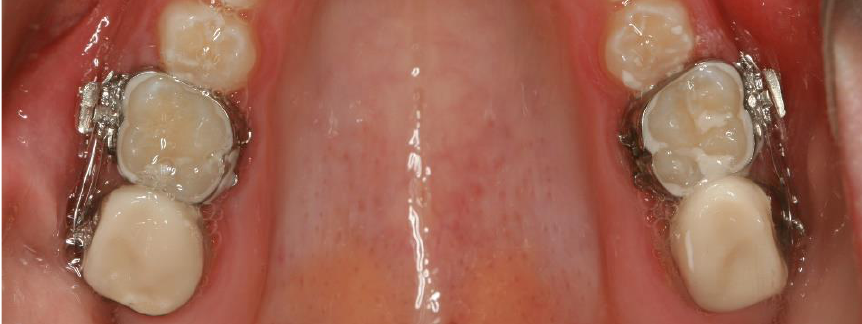
Figure 4. Crowns (with safety hooks) were produced using 3D computer design and additive manufacturing technology (selective laser melting (SLM)).